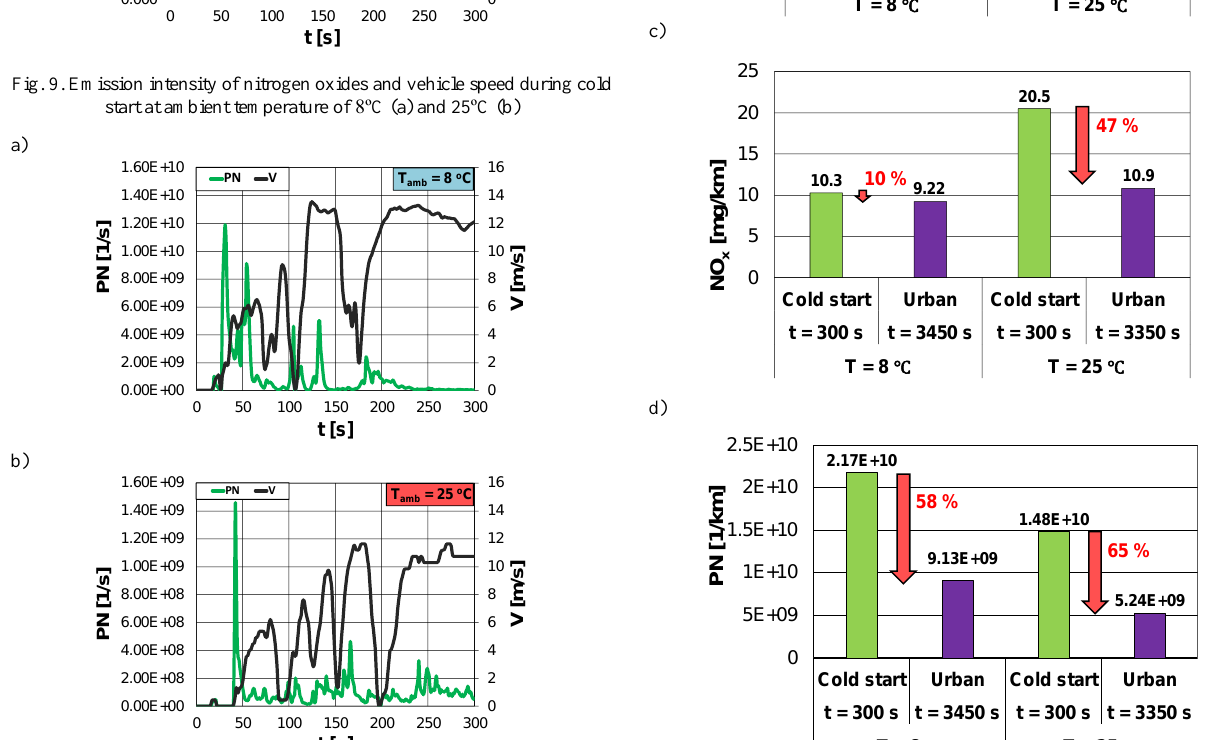
Fig. 11. Road emissions of CO (a), CO 2 (b), NO x (c), PN (d) at two differ- ent ambient